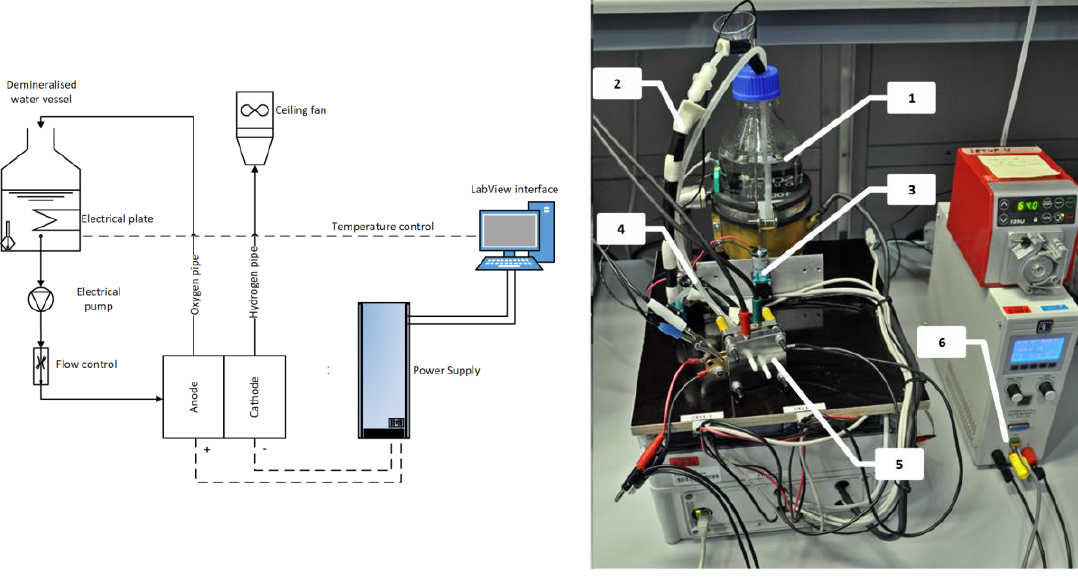
Figure 1. ( Left ) P&ID of the test setup; ( Right ) Experimental setup for single cell operation. (1) Deionized water bottle; (2) Anode water supply pipe; (3) Water supply pump; (4) Anode recirculation loop; (5) hydrogen outlet; (6) Electrical power supply.